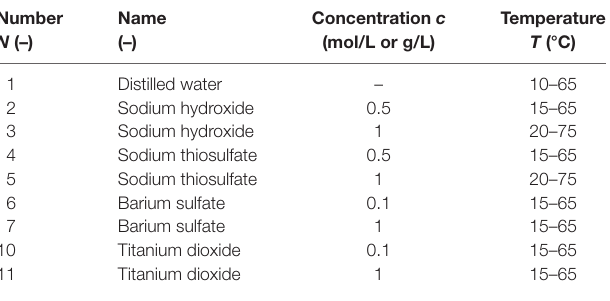
Table 1 | Concentration and temperature range of different